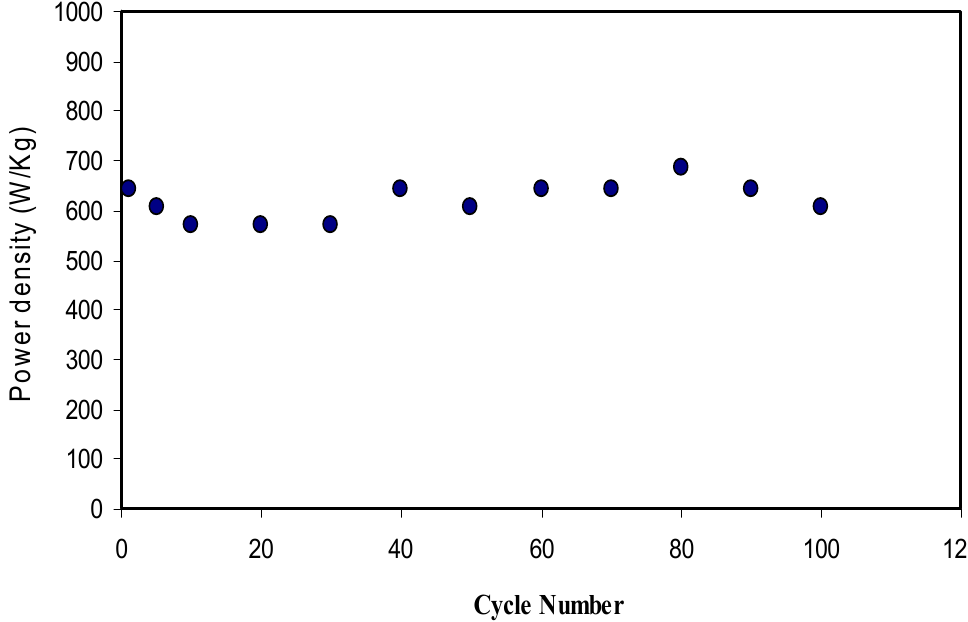
Figure 16. Power density of the fabricated EDLC for 100 cycles.